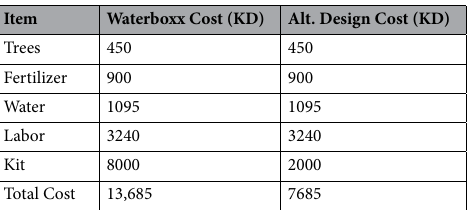
Table 4. Waterboxx & alternative design items’ cost for three-year life span.